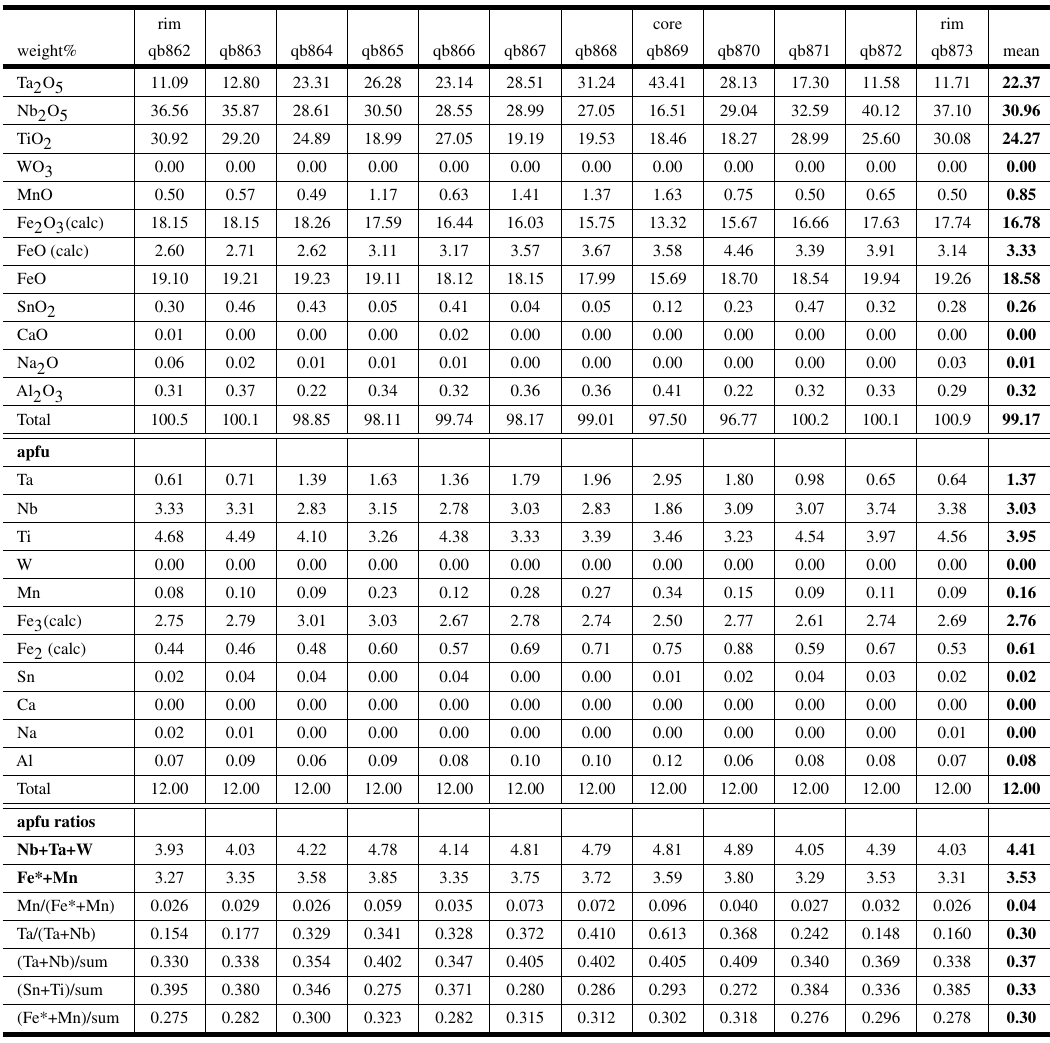
Microprobe analyses along a cross section of a titanian ixiolite crystal (same points represented in Figure 4C). Data from